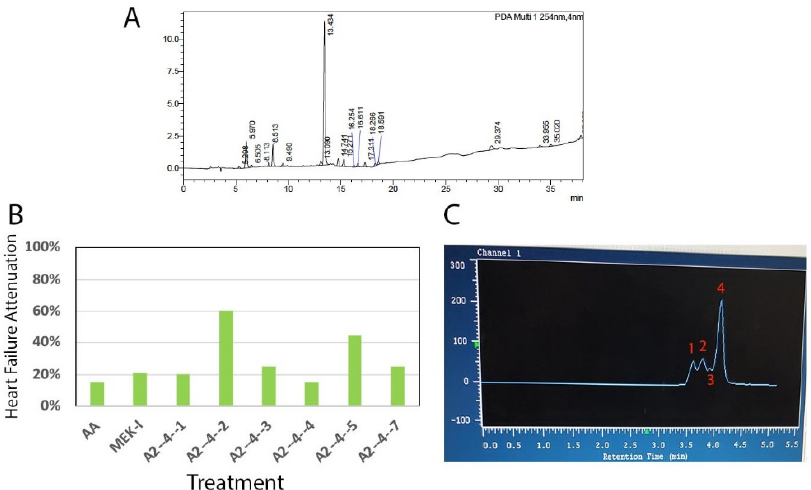
( B ) The A2-4 fraction was further separated into seven fractions, A2-4-1 to A2-4-7. Among them, A2- 4-2 showed the highest AHF attenuation activity. ( C ) A representative UV absorbance graph during the preparative HPLC for A2-4-2 revealed that the A2-4-2 fraction contains four UV absorbance peaks which are significantly overlapped. Although extreme care was taken to separate the compounds into the final four fractions, named A2-4-2-1 to A2-4-2-4, the NMR analysis eventually showed impurities in A2-4-2-4 (see Figure 3).